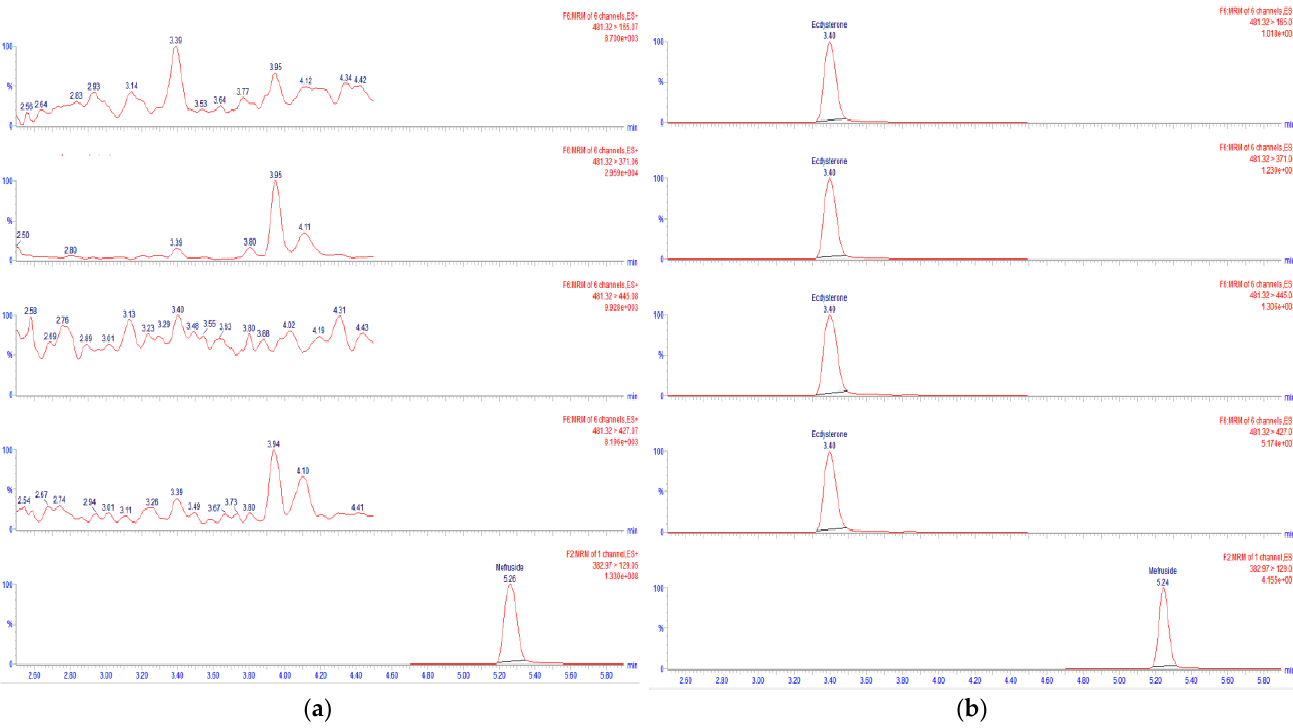
Figure 3 . Chromatograms from the analysis of a sample dietary supplement ( a ) blank sample; ( b ) fresh spinach sample .